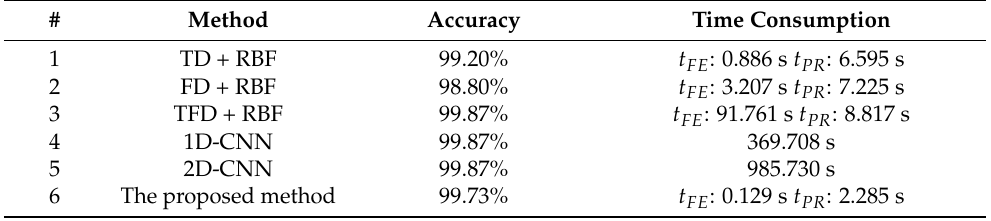
Table 6. Comparisons based on maintenance level recognition of